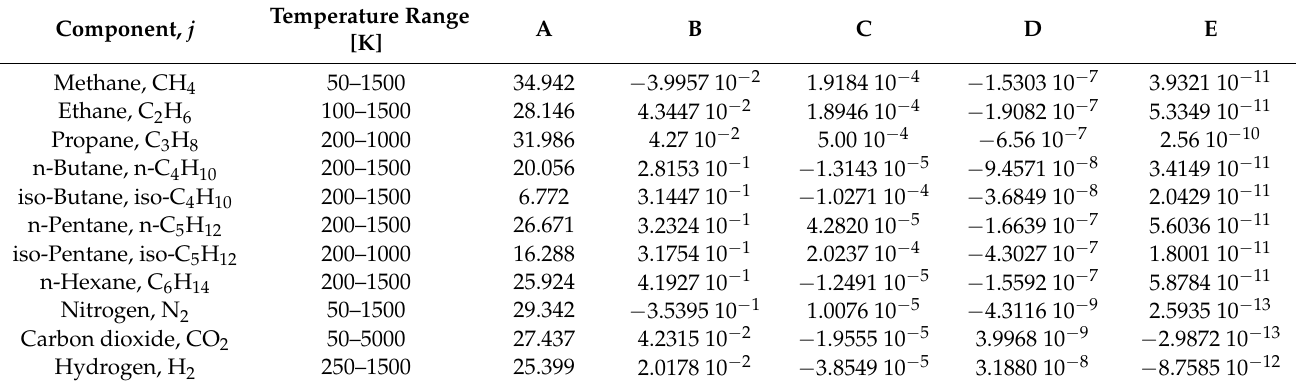
Table 1. Regression coefficients of gas components